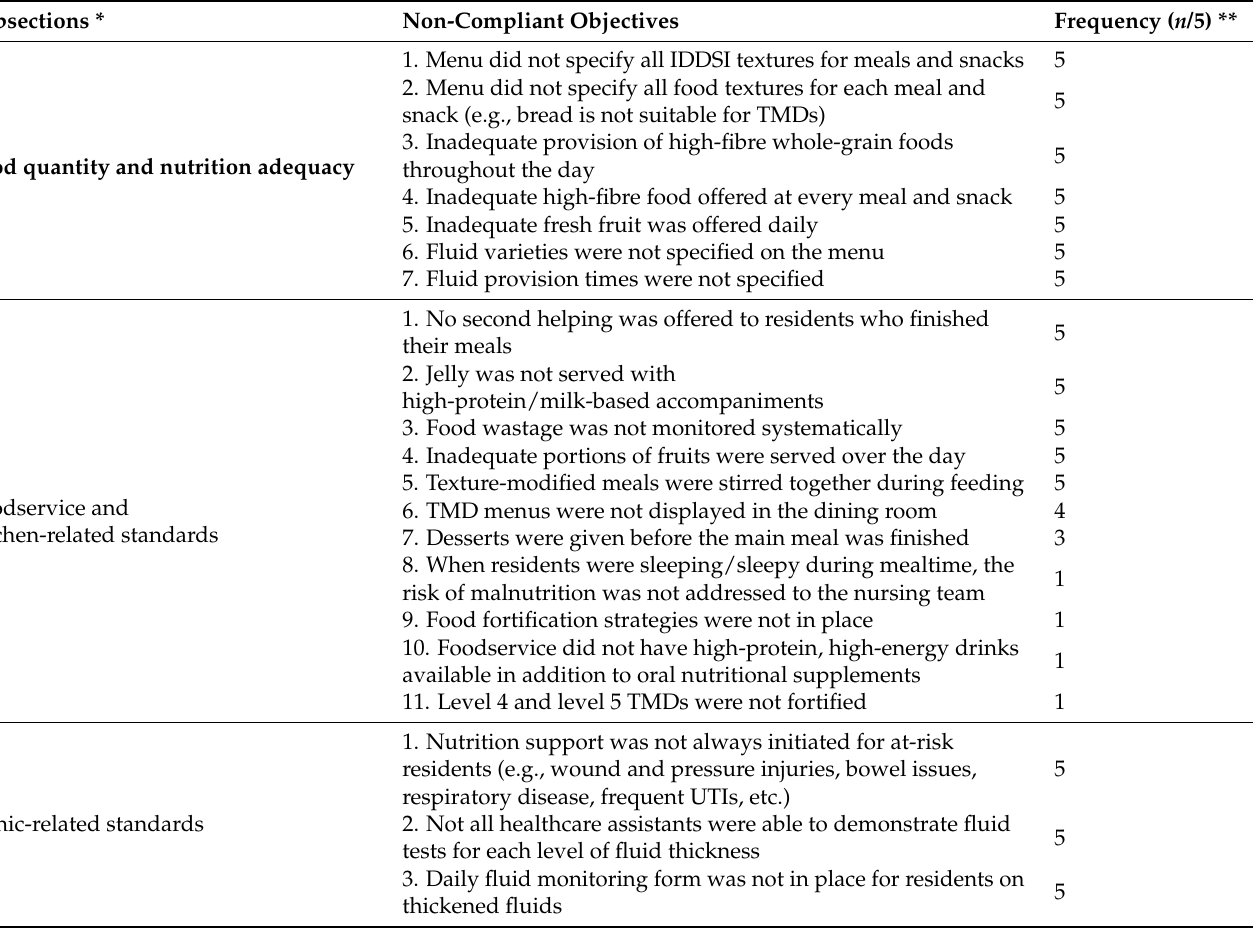
Table 2. Non-compliant objectives in texture-modified menus identified via menu audits in five aged care facilities, ranked by compliance failure